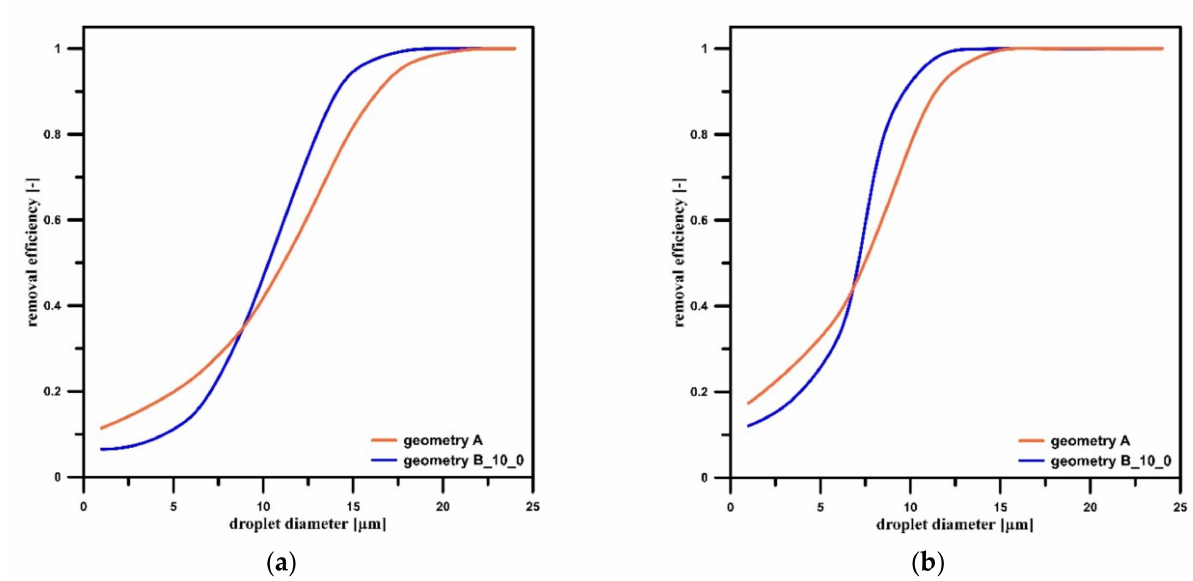
Figure 8. Comparison of calculated results of droplet removal efficiency for geometries A and B_10_0 with inlet velocity: ( a ) 2 m s − 1 ; ( b ) 4 m s − 1